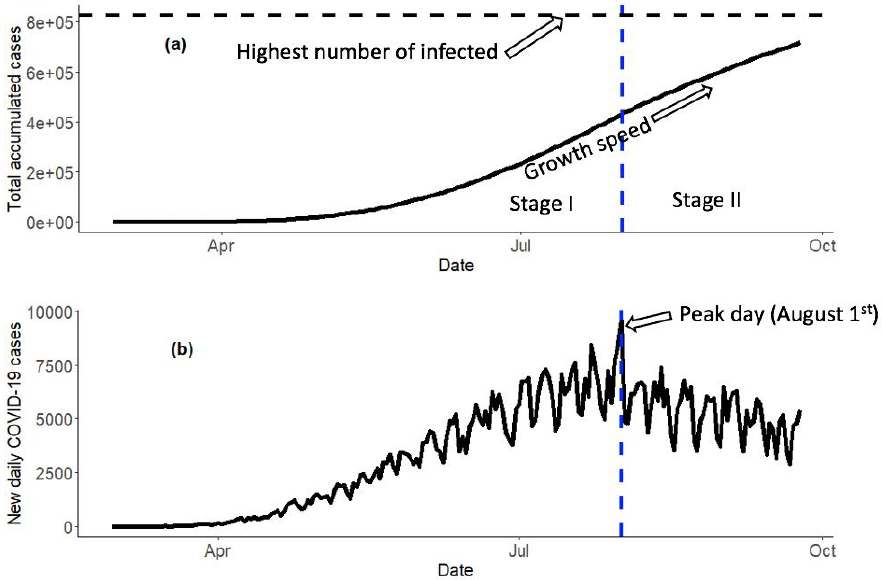
Figure 1. ( a ) Accumulated cases and ( b ) new daily cases of COVID-19 in